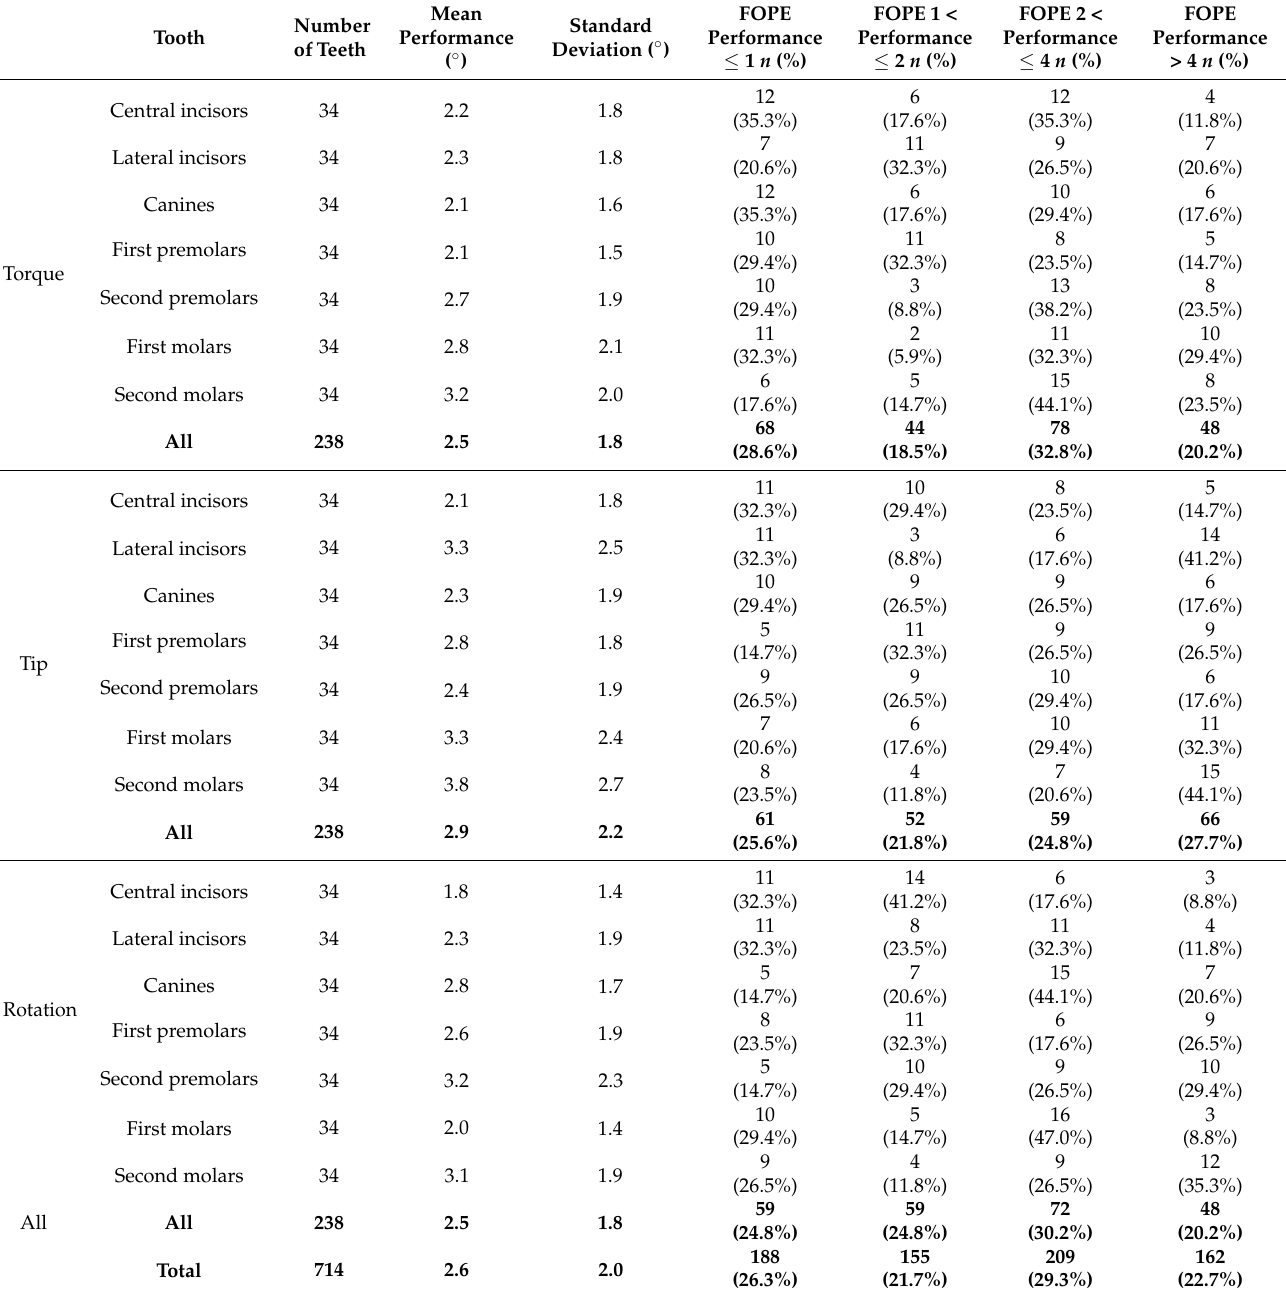
Table 3. Performance of the achieved